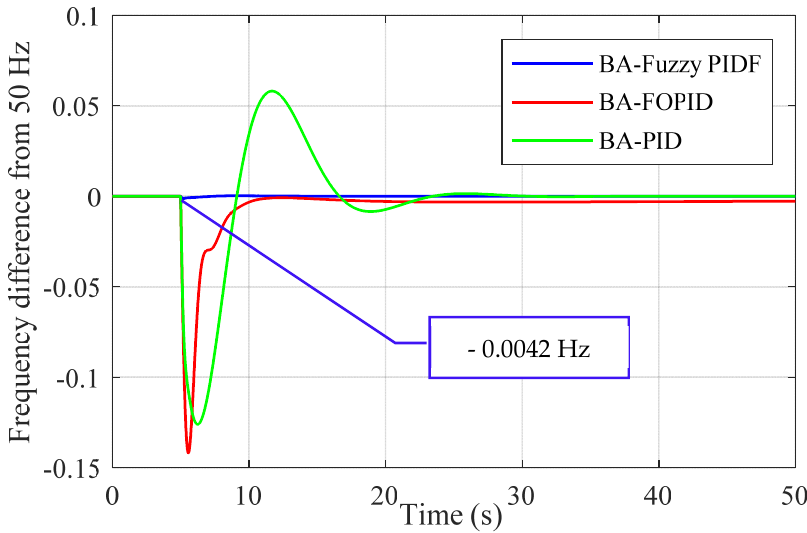
Table 16. Frequency response performance with different BA-tuned controllers designed via ITAE for scenario 2.